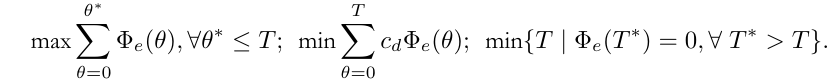
Algorithm 2 Multi-terminal dynamic transshipment feasibility